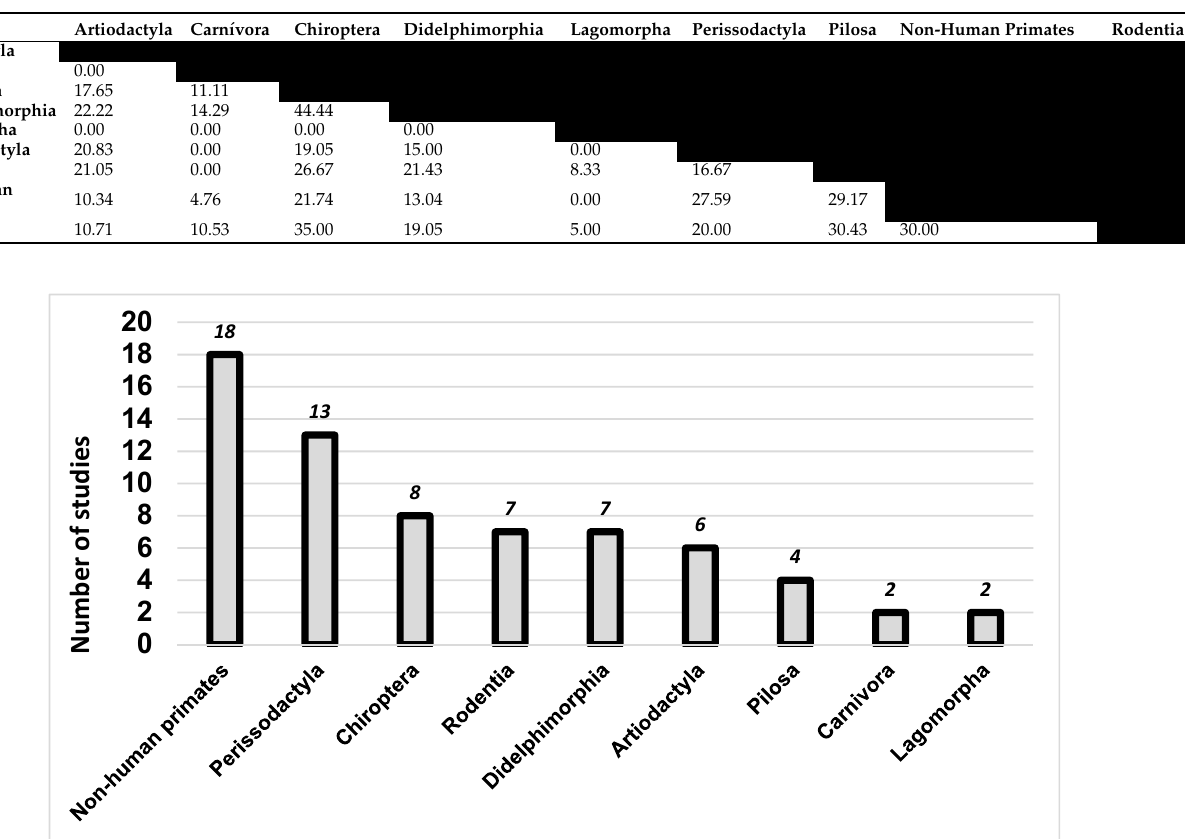
Figure 2. Arbovirus sampling effort in the Neotropics by order of mammal decreasing order.